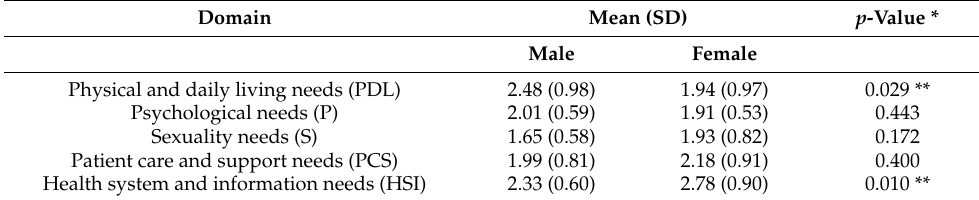
Table 4. Comparison of gender with SCNS-SF34 Malay domains